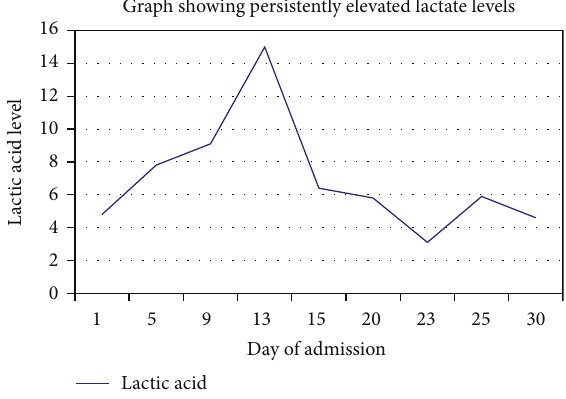
Figure 5: Graph showing persistently elevated lactic acid